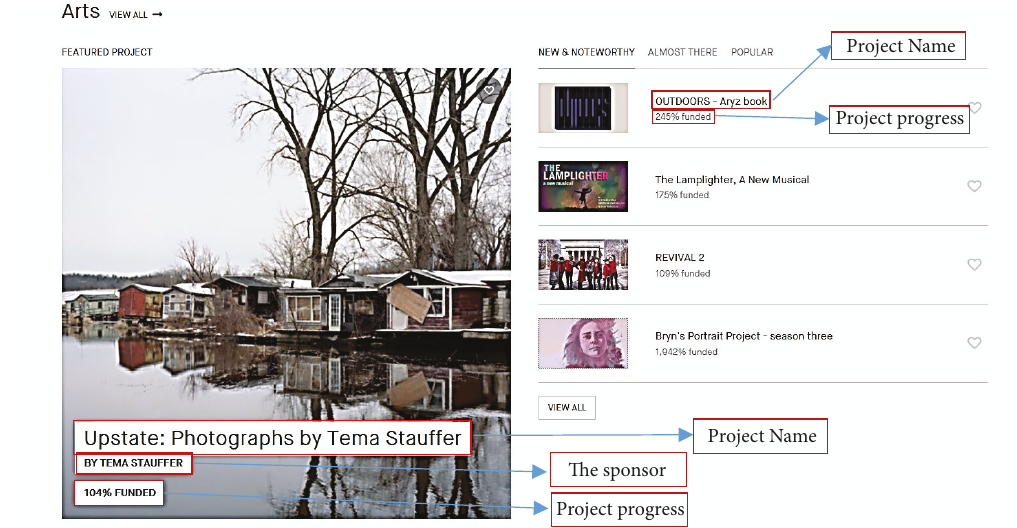
Figure 1: One webpage on